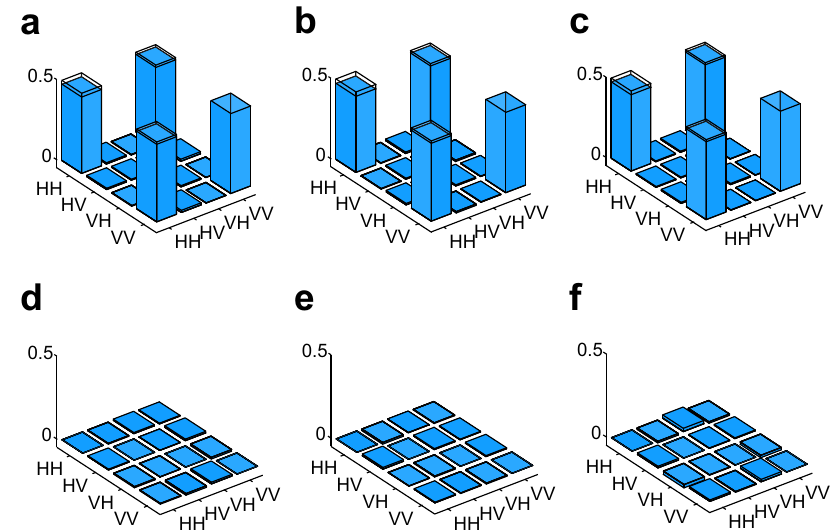
Fig.6|TomographicresultsofthethreeEPRsources. Thetopandbottomplots in each column show, respectively, the real and imaginary parts of the recon- structed density matrices corresponding to the states distributed by the sources